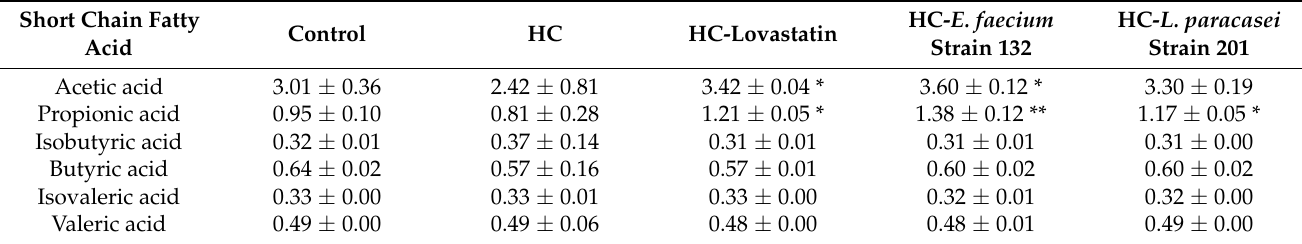
Table 3. The content of short chain fatty acids.